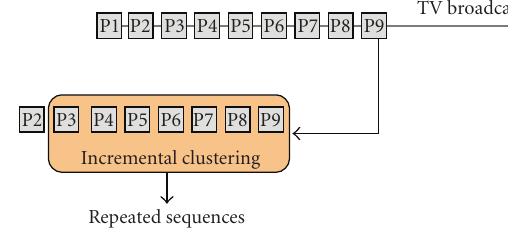
Figure 4: Working scheme of incremental clustering.